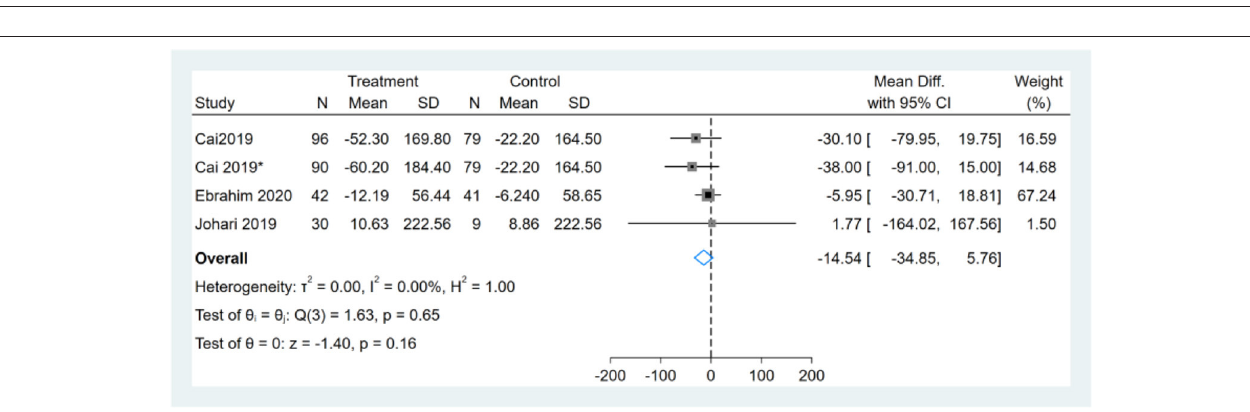
Frontiers in Nutrition |